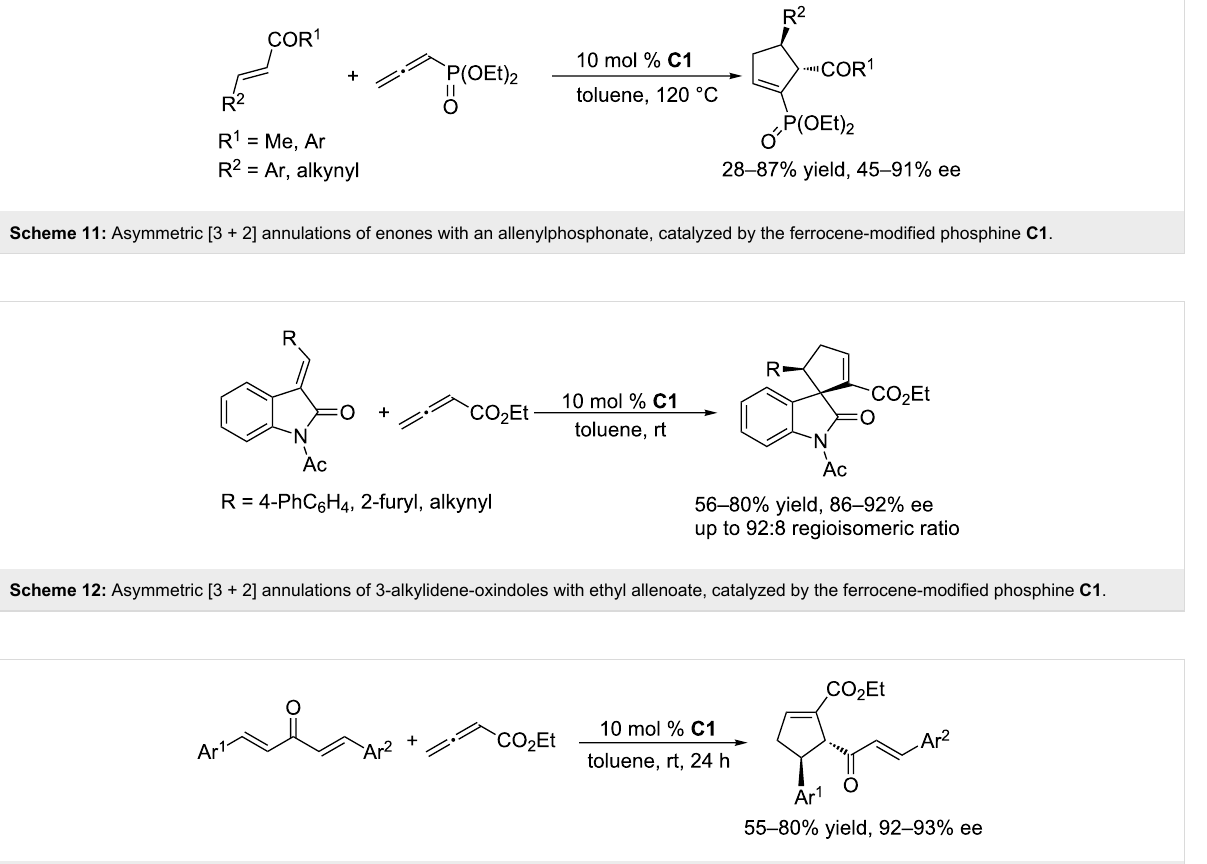
Scheme 13: Asymmetric [3 + 2] annulations of dibenzylideneacetones with ethyl allenoate, catalyzed by the ferrocene-modified phosphine C1